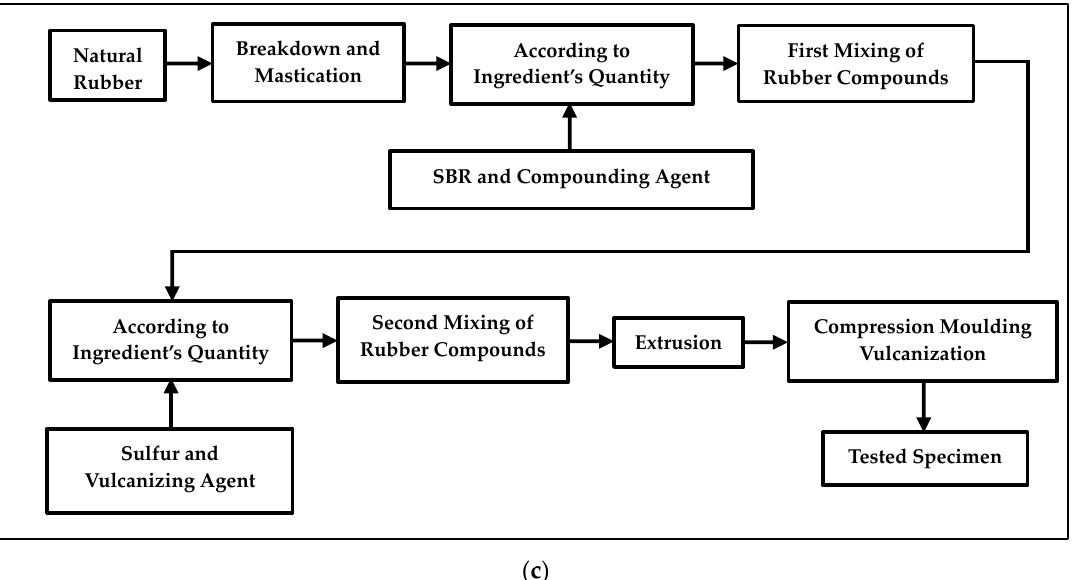
Figure 1. ( a ) Geometry and dimensions of tested hollow-cylinder rubber fenders, and ( b ) experimental setup for monotonic tension tests, and ( c ) the manufacturing processes of the rubber fender provided by the supplier. Table 1. Composition of the rubber fenders used in the present study.